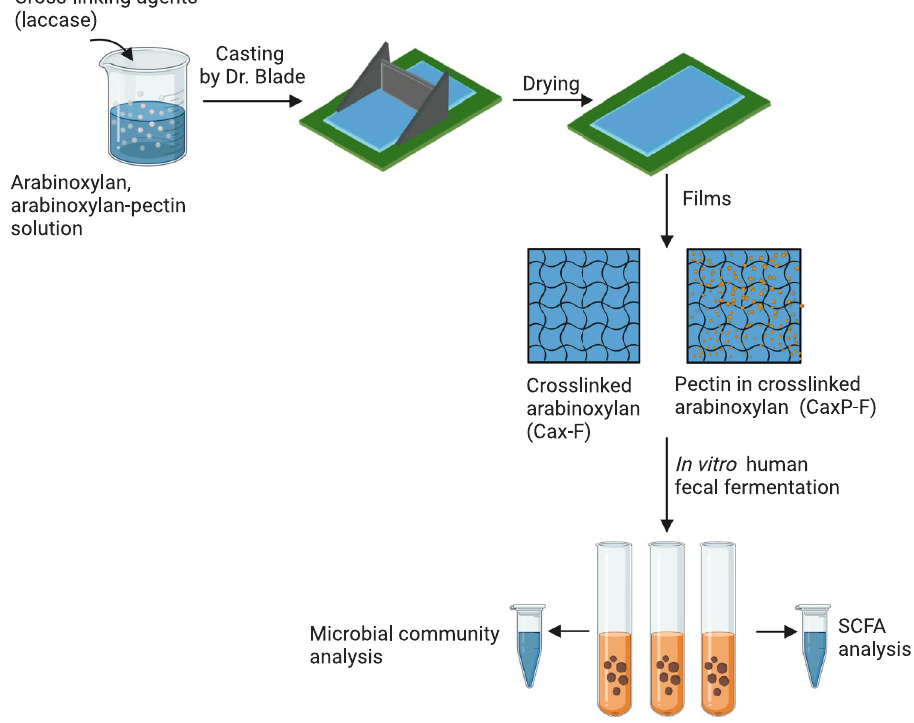
Figure 1. Diagram of film preparation and experimental design. The graphic summary depicts the film casting, the structure of the thin films, and the in vitro human fecal fermentation